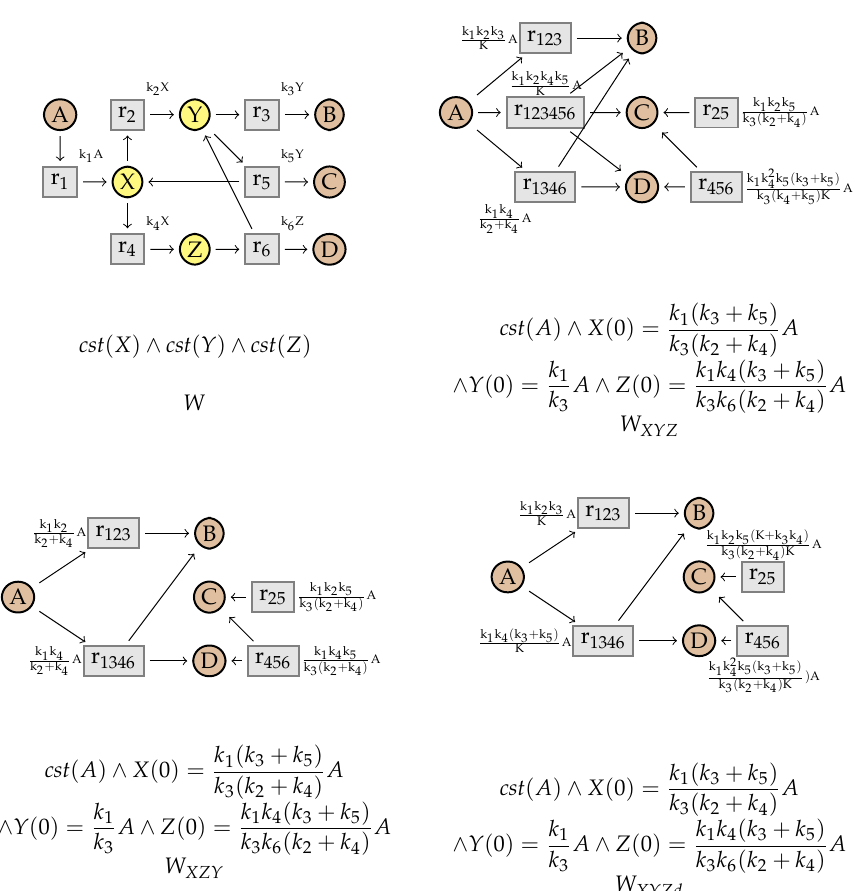
Figure 22. Network W and its simplifications. ( top left ) Network W . ( top right ) Network W XYZ after eliminating X , Y and Z (in this order). ( bottom left ) Network W XZY after eliminating X , Z and Y . ( bottom right ) Network W XYZd after eliminating X , Y , Z , and the dependent reaction. The new parameter is K = k 2 k 3 + k 3 k 4 + k 4 k 5